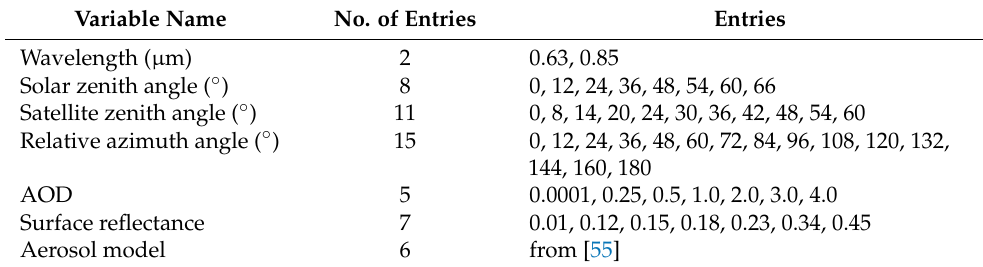
Table 3. Dimensions of the LUT for aerosol